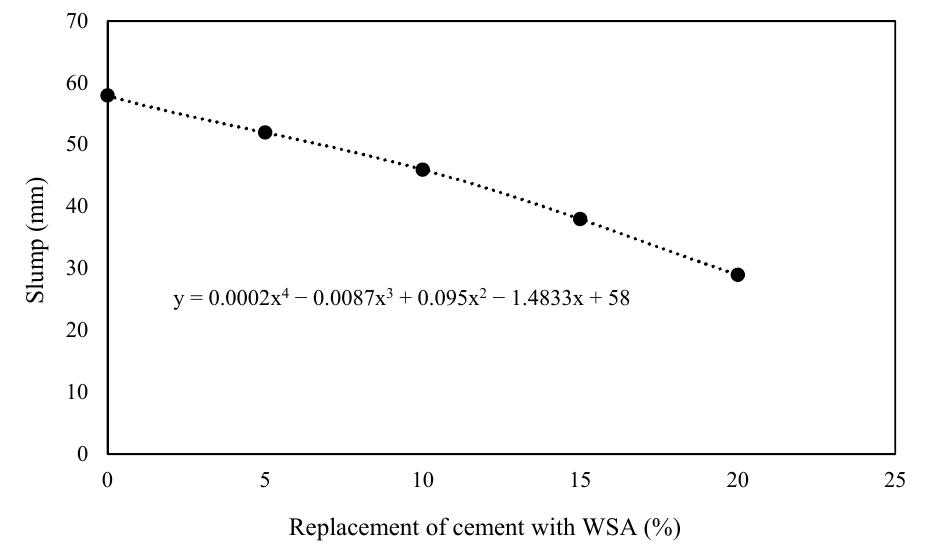
Figure 1. Workability of concrete containing wheat straw ash.